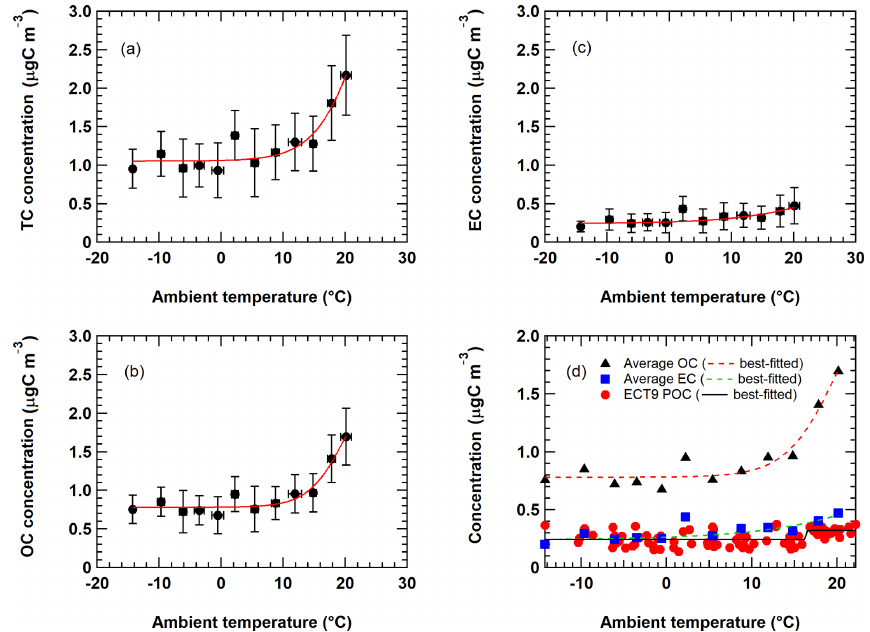
Figure 8. Figure shows the relationship of averaged (a) TC, (b) OC, and (c) EC concentrations from all networks as a function of ambient temperature. Each data point represents the average value of all network measurements within a 3 ◦ C temperature range. Uncertainties are standard deviations of the measurements. The red curve represents the best-fitted sigmoid function. Figure 8d shows the seasonality of ECT9 POC compared to the average OC and EC seasonality. The black solid curve represents the best-fitted sigmoid function on all ECT9 POC